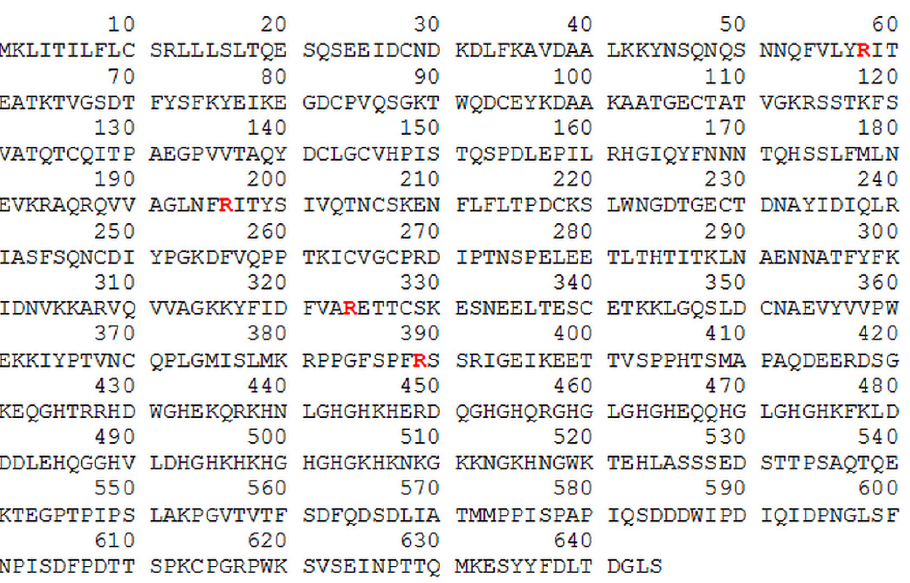
Figure 8. HK sequence, with arginine residues labelled in red text, identified by LC-MS / MS and as putatively modified by PPAD. The human HK sequence was obtained from the UniProtKB database - P01042 (KNG1_HUMAN) record [41].